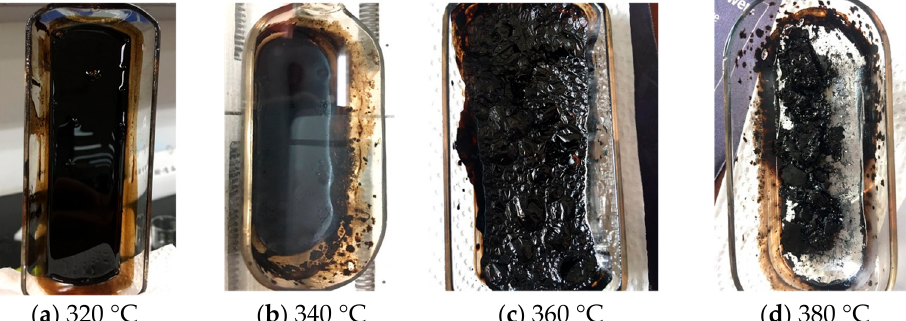
Figure 6. Coking evolution at different temperatures (nitrogen environment, ( a , b , c , d ) subfigure means the coking test result under 320, 340, 360, 380 °C, respectively).